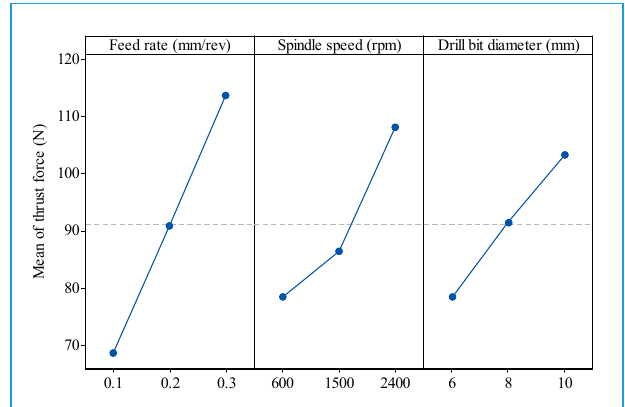
Figure 3. The main effects for thrust force.